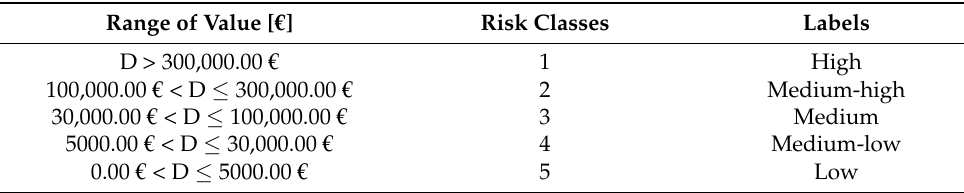
Table 7. Allocation of risk classes to Coastal Flooding.